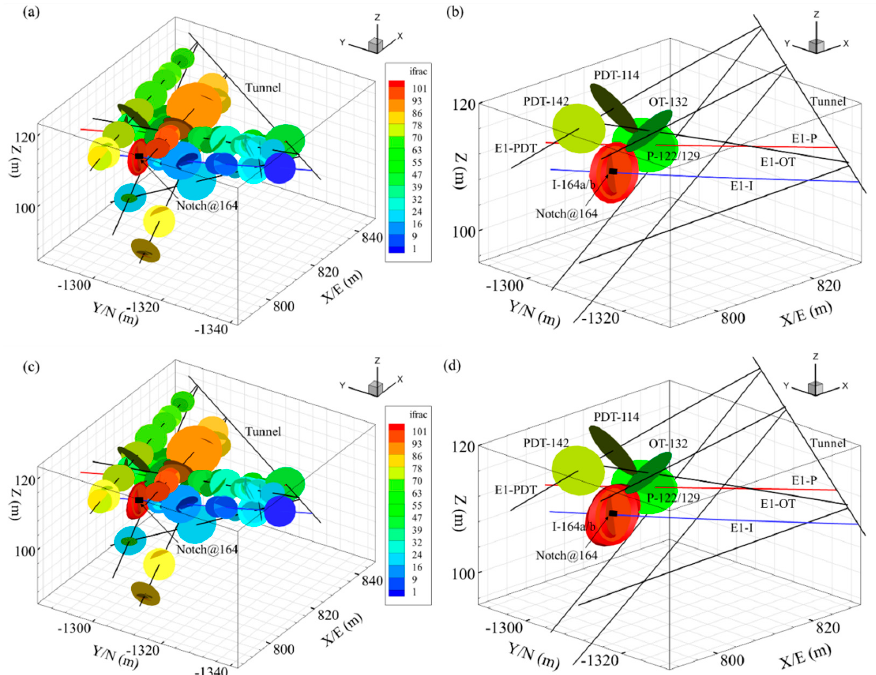
Figure 13. The results from numerical simulation: ( a , b ) show the propagation of I-164a/b at T22:44. The length of intersection between I-164b and OT-132 is relatively small (0.1 m). ( c , d ) is the propagation of I-164b at T22:45. The distance for intersection between I-164b and P-129 is relatively small (~0.1 m). Injection well E1-I partly connects with production well